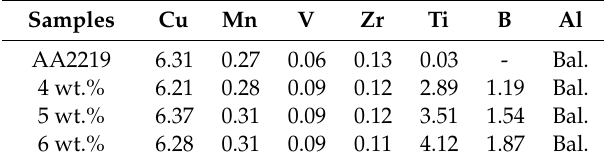
Table 1. The mass fractions of chemical compositions of the alloy and composite.